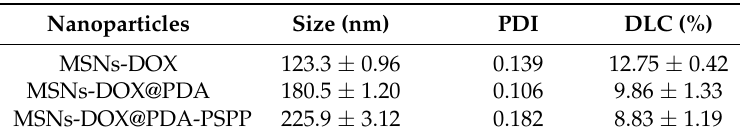
Table 2. Characterization of DOX-loaded nanoparticles.